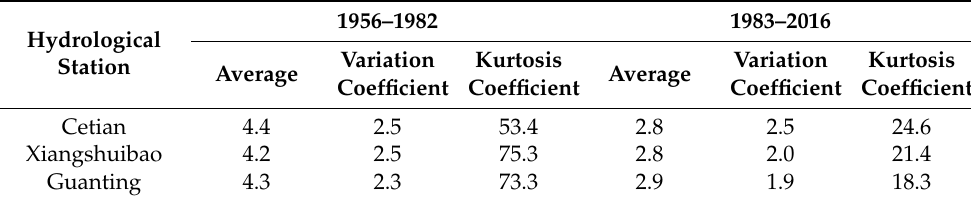
Figure 6. Probability distribution histogram of daily precipitation in different reservoir control basins. ( a ) the probability distribution histogram in the control basin of Cetian reservior; ( b ) the probability distribution histogram in the control basin of Xiangshuibao reservior; ( c ) the probability distribution histogram in the control basin of Guanting reservior. Table 3. Daily precipitation statistics of different meteorological stations from July to